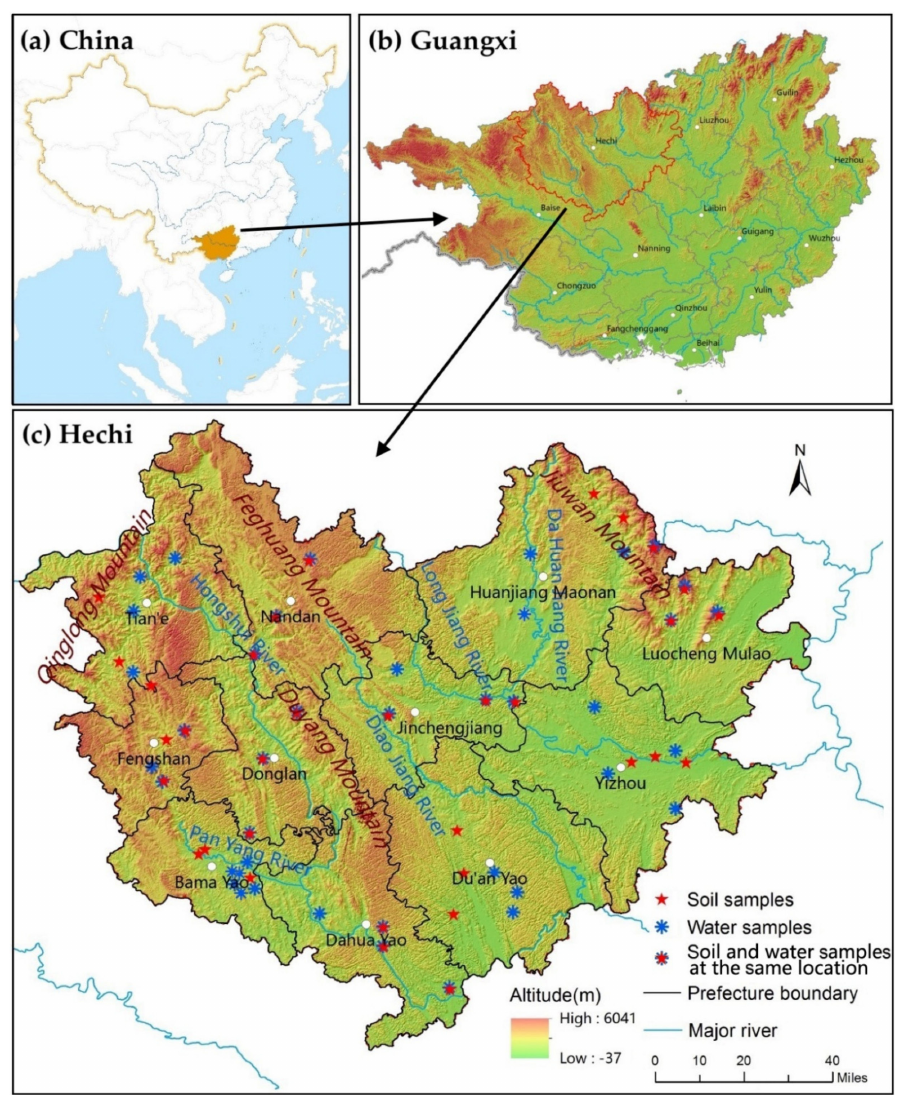
Figure 1. Location of Hechi and its sampling sites( c ) in Guangxi ( b ), China ( a